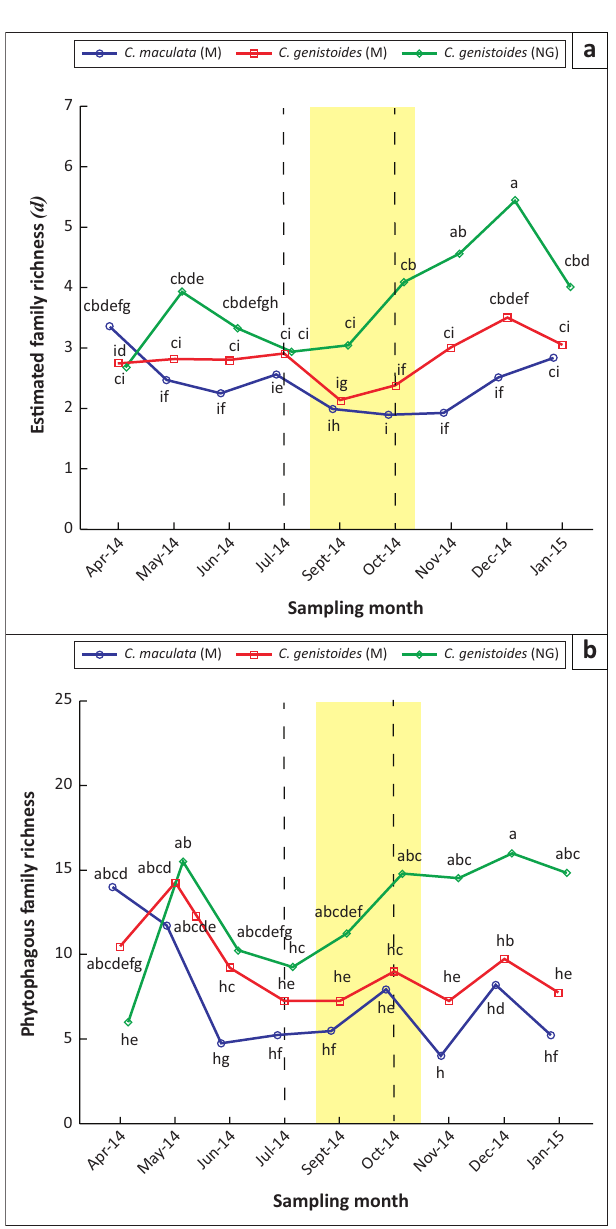
FIGURE 5: (a) Estimated family richness and (b) phytophagous family richness of the arthropod assemblage associated with mature (M) and new growth (NG) stands of Cyclopia spp. by d-vac sampling from April 2014 to January 2015, field sites in the Overberg, South Africa. Different alphabetical letters indicate significant differences within and across months (restricted maximal likelihood, least squares distance post hoc). To simplify graph interpretation, 95 % confidence intervals have been omitted. The dashed lines indicate the initial leaf budding for Cyclopia maculata (July/August) and Cyclopia genistoides (October), respectively. Fruiting is initiated in October for both species after the flowering period (yellow band) in September to